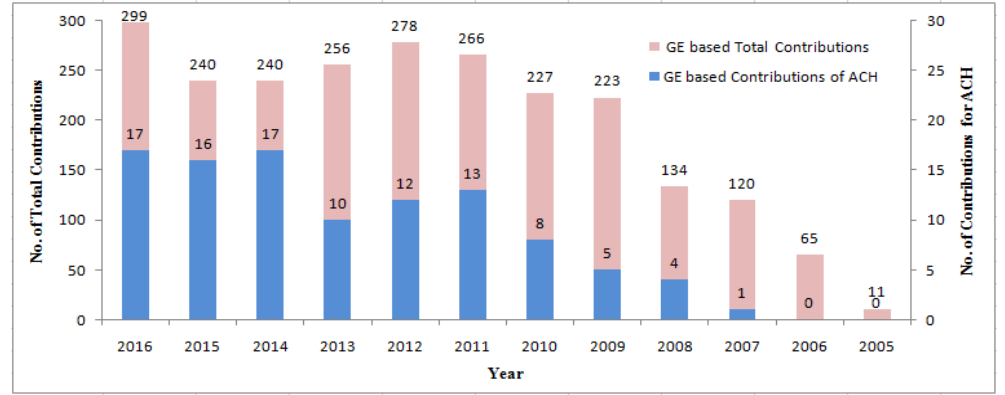
Figure 2. Annual literature counts of contributions introducing GE applications, extracted from the database Scopus published from 2005 to 2016 (last access 15 May 2018).